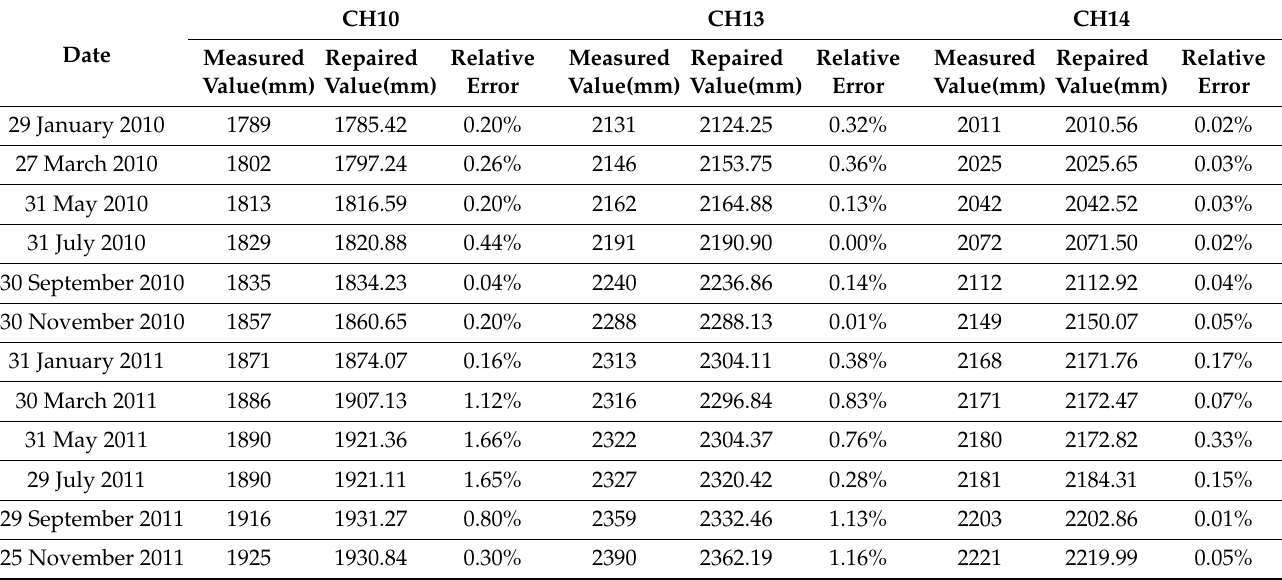
Table 4. Repair accuracy of measuring